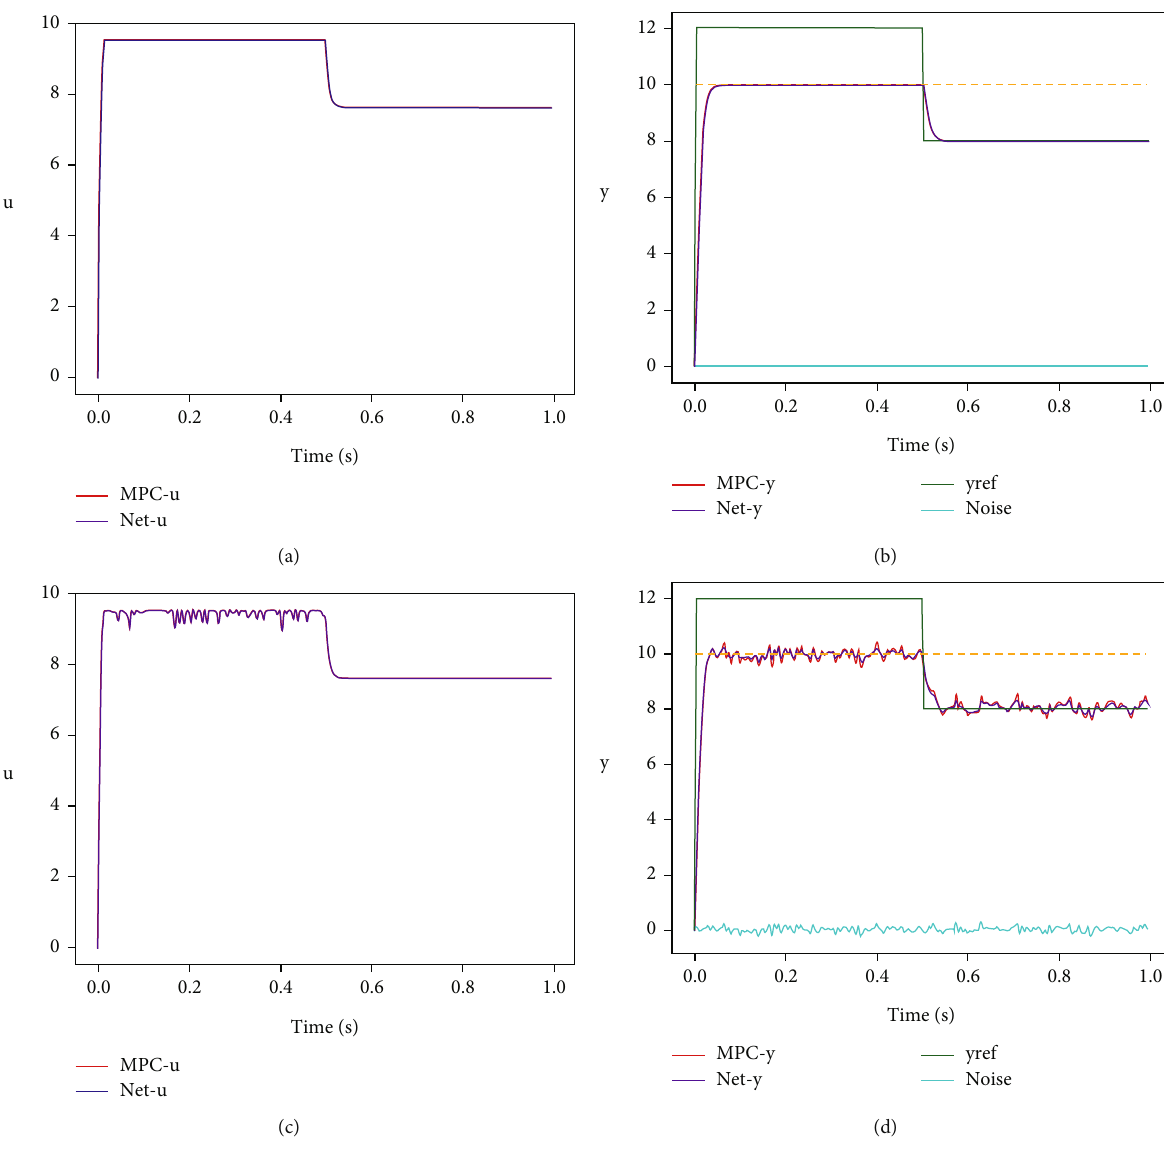
ref touches the constraint